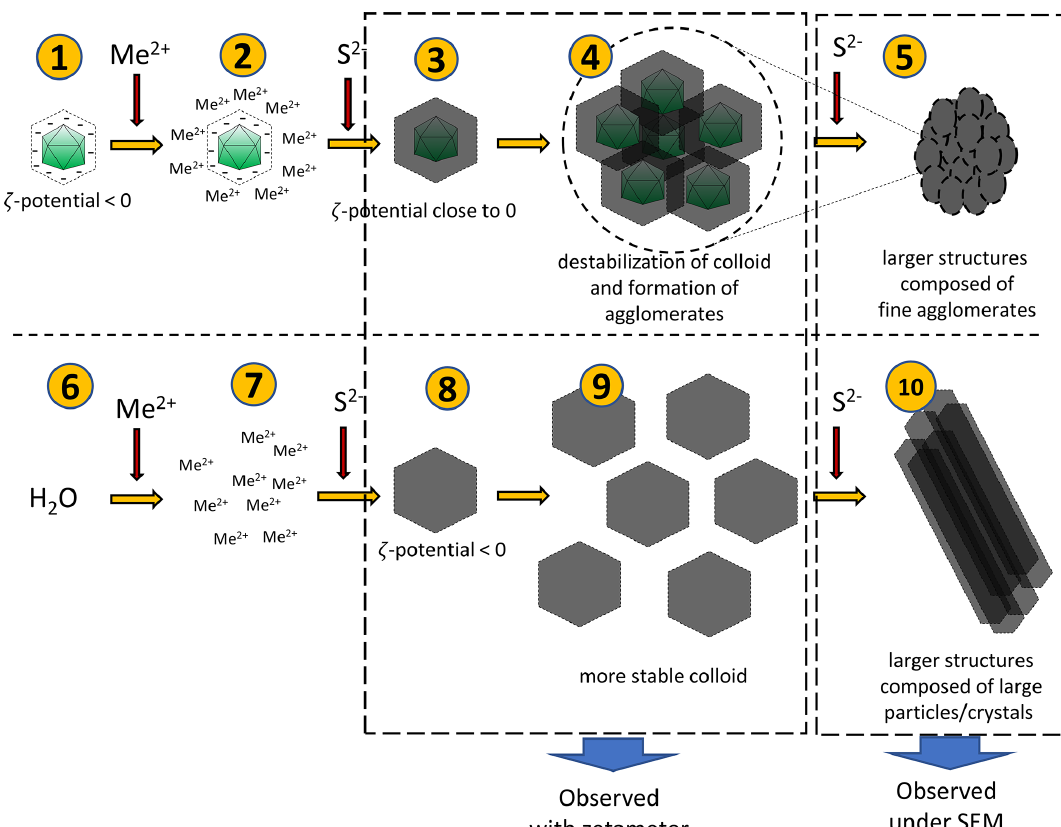
Figure 10. Hypothetical processes leading to the observed phenomena. Negatively charged bacteriophage capsids bind metal ions (1–2). When sulfide ions are added in small quantities, sulfides will precipitate on capsids (3). Due to a surface charge close to zero, the colloid undergoes destabilization and agglomerates can be formed (4). Addition of more sulfides can promote the creation of more such agglomerates, which can lead to the larger structure (composed of small agglomerates) (5). The addition of a small portion of sulfides in the experiment without bacteriophages (6–8) can lead to the formation of a more stable colloid due to lower ζ potential (9). However, the addition of more sulfide ions causes further growth of crystals and formation of larger structures composed of large particles or